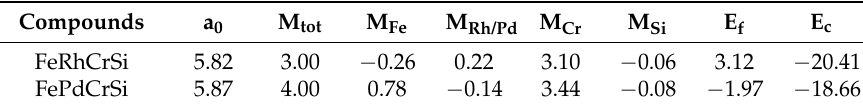
Figure 2. Energy optimization with different crystal structures of ( a ) FeRhCrSi and ( b ) FePdCrSi. Table 2. The optimized equilibrium lattice constant a 0 (Å), the total and partial magnetic moments ( µ B ) at the equilibrium lattice, the formation energy E f and cohesive energy Ec (eV) for the equiatomic quaternary Heusler (EQH) compounds FeRhCrSi and